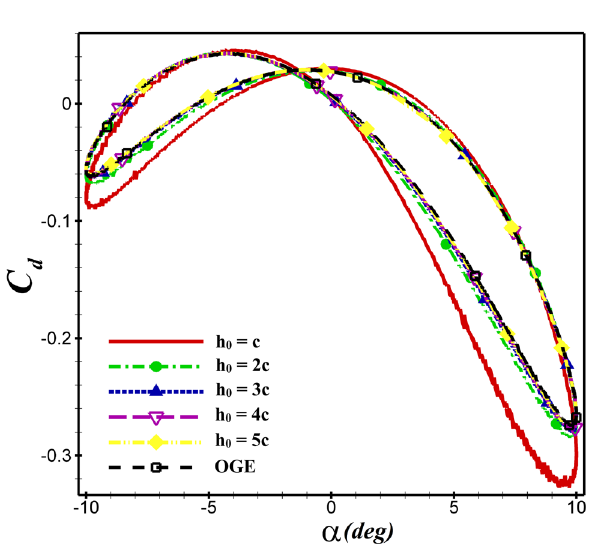
Figure 11. The C d of NACA 4412 airfoil in different h 0 over one oscillation